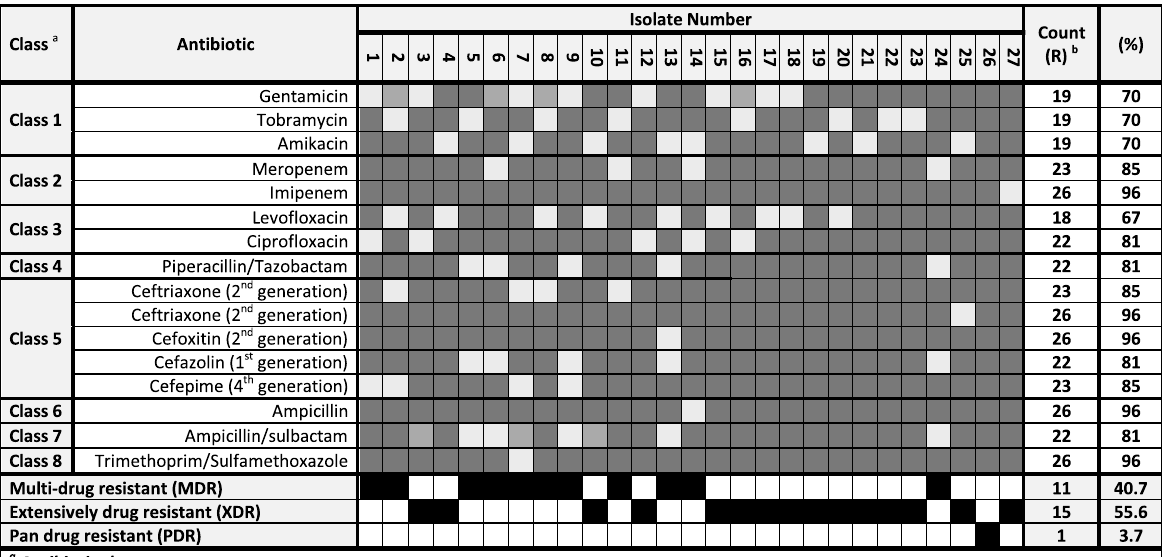
Table 3 Antibiotic resistance pattern among the different Klebsiella isolates